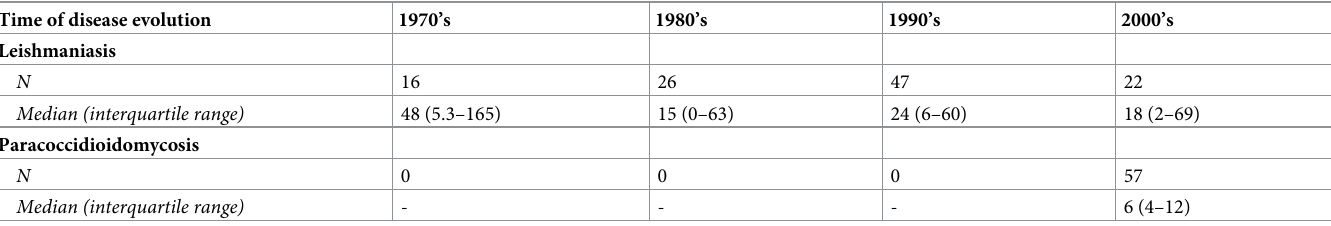
Table 2. Time of disease evolution (months) in leishmaniasis and paracoccidioidomycosis along the decades. Time of disease